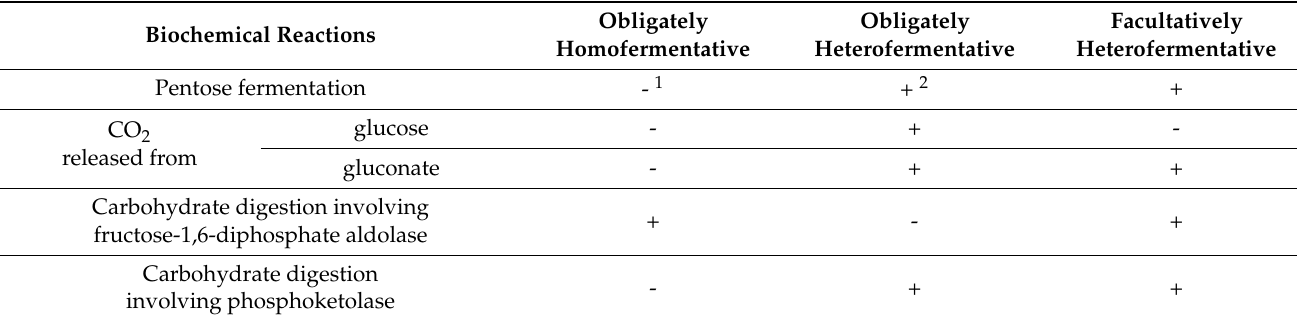
Table 5. Selected biochemical reactions carried out by lactobacilli with different carbohydrate fermentation patterns [1,71,106]. Biochemical